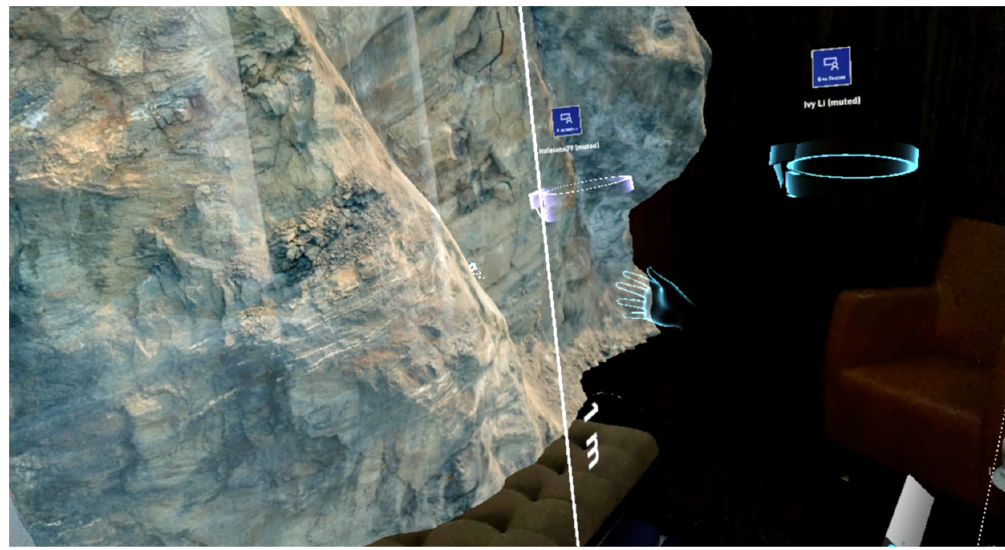
Figure 7. Shared session within ADA Platform, from the point of view of one of the 3 HoloLens devices connected to a remote session. In this example, two users are remote, thus they appear only as avatars (headset hologram with their nickname). One virtual hand is also visible to highlight where the pointer is aiming to (picture courtesy of BGC/Clirio).